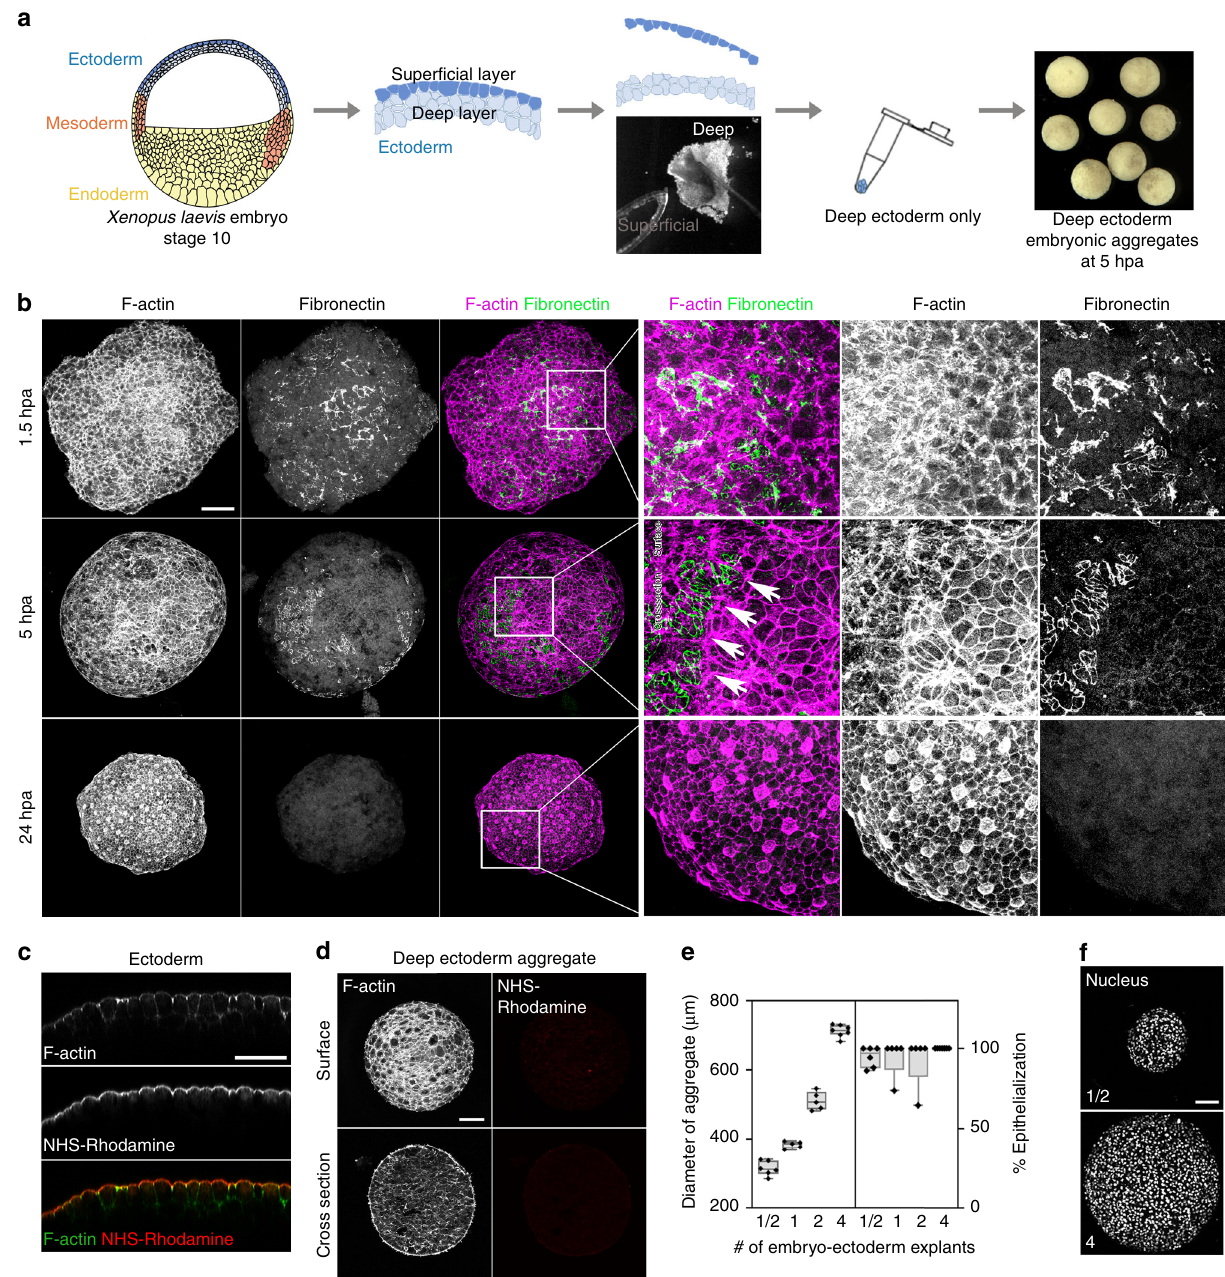
Fig. 1 Surface cells of deep ectoderm aggregates undergo epithelial-like phenotypic transition. a Schematic of the assembly of deep ectoderm cell aggregates from early Xenopus embryo (Stage 10). b Surface F-actin and fi bronectin (FN) from maximum intensity projections at 1.5, 5, and 24 h post aggregation (hpa). Three panels on the right are higher resolution views of the inset region (white box) in the third column. Arrows indicate margin of FN where dense circumapical F-actin suggests epithelial cell phenotype. Scale bar for aggregate images is 100 µ m. c Transverse sectional view through the ectoderm of NHS-Rhodamine surface-labelled embryos. Scale bar, 50 µ m. Rhodamine is restricted to the apical surface of outer epithelial cells. d Deep ectoderm aggregates generated from NHS-Rhodamine surface-labelled embryos. Scale bar, 100 µ m. Lack of rhodamine indicates absence of contaminating epithelia. e Percent of epithelial cell phenotype found on the surface of different-sized deep ectoderm aggregates at 24 hpa. Aggregates assembled with varying amounts of embryo-ectoderm explants (1/2 explant, n = 6; 1 explant, n = 5; 2 explants, n = 5; 4 explants, n = 8). Box plot shows minimum, fi rst quartile, median, third quartile, and maximum values. f Labeled nuclei shown in deep ectoderm aggregates from 1/2- and 4-embryo-ectoderm explant containing aggregates. Scale bar, 100 µ Epithelialization and YAP translocation as tissue stiffens . What random epithelial patches across the surface (Fig. 2c, d) suggests triggers de novo epithelialization and goblet cell differentiation of that cells respond to locally varying mechanical conditions. To test the surface-layer cells in aggregates? Unlike deep ectoderm cells if cells might be responding to changes in their mechanical in vivo, deep ectoderm cells on the surface of aggregates are microenvironment, we analyzed the localization of Yes-associated unconstrained by adjacent epithelia. Emergence of apparently protein 1 (YAP), a transcription factor whose nuclear translocation